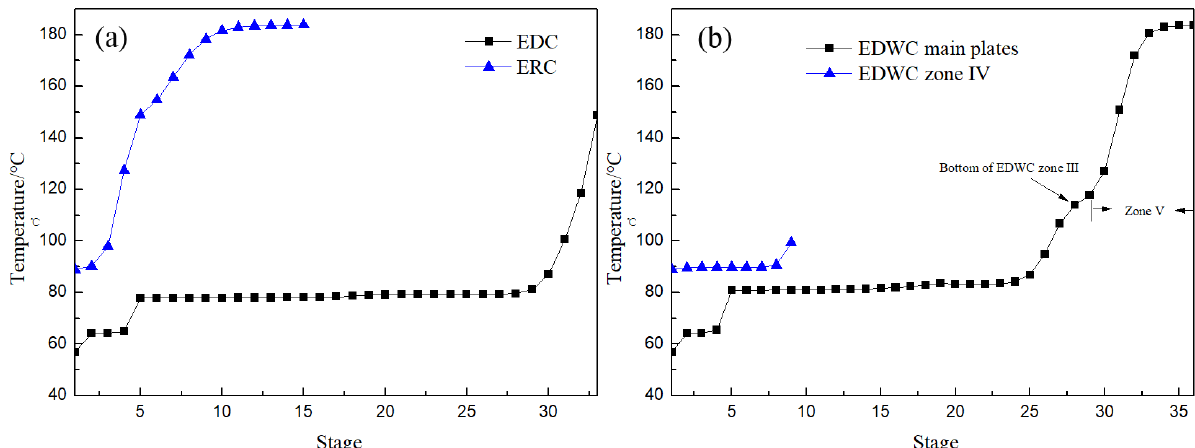
Figure 15. Temperature profiles of CEP ( a ) and EDWC ( b ).